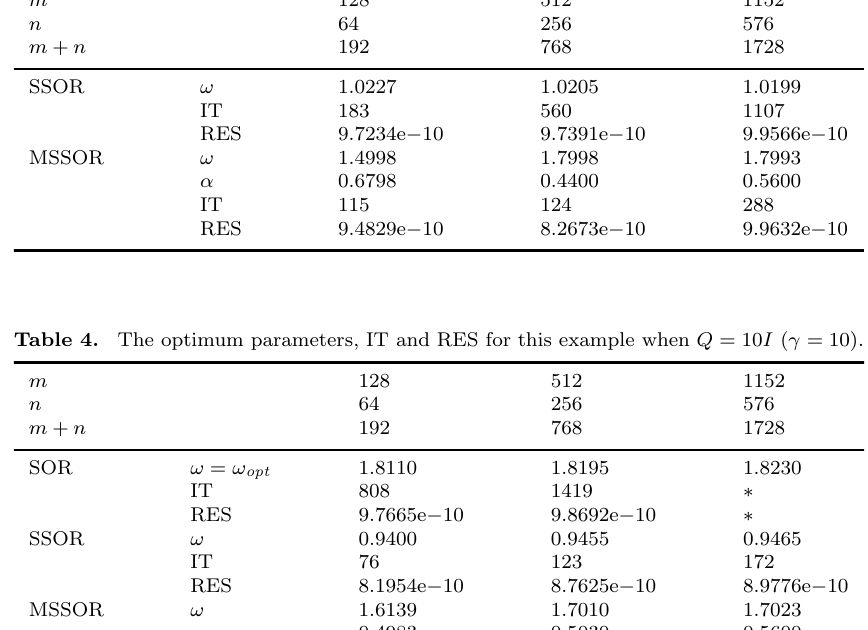
Table 3. The optimum parameters, IT and RES for this example when Q = − B T B ( τ = − 1). m